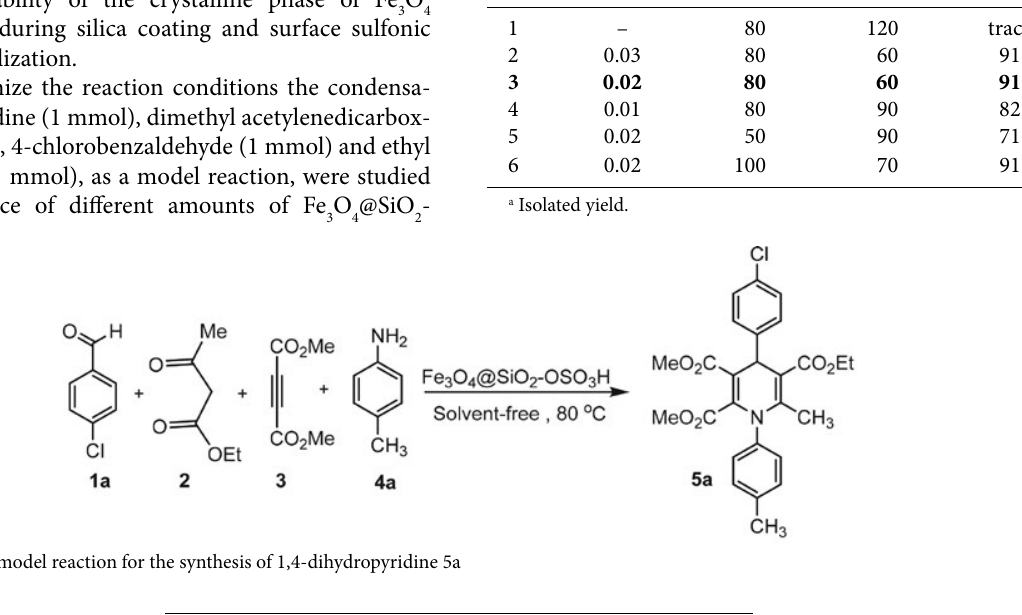
O @SiO -OSO H nanocomposite 3 4 2 3